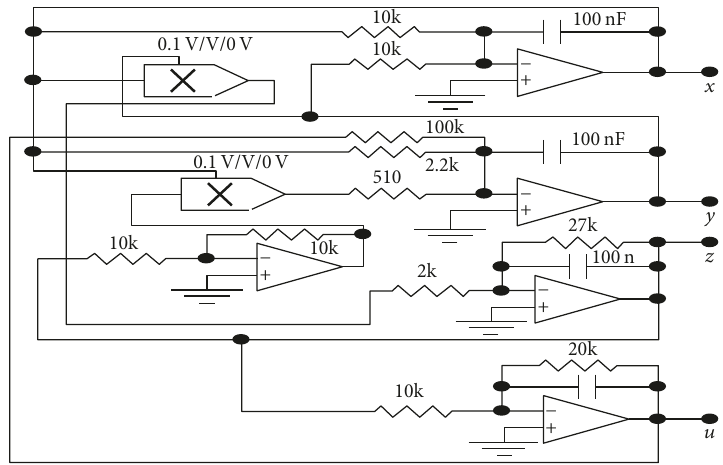
Figure 11: 𝑧 - 𝑢 - 𝑦 hyperchaotic circuit schematic.